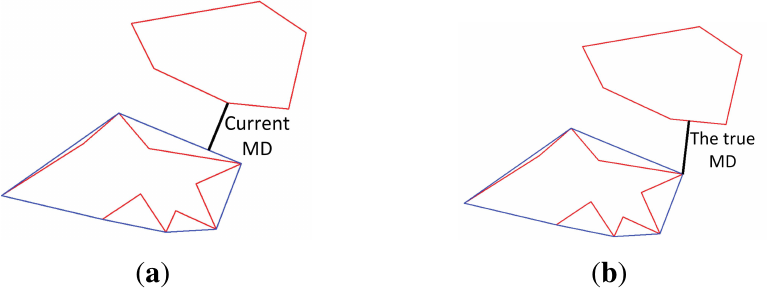
Figure 18. The computed and genuine minimum distances (MDs) between a convex and a non-convex obstacle. ( a ) The computed MD in our approach; ( b ) the genuine